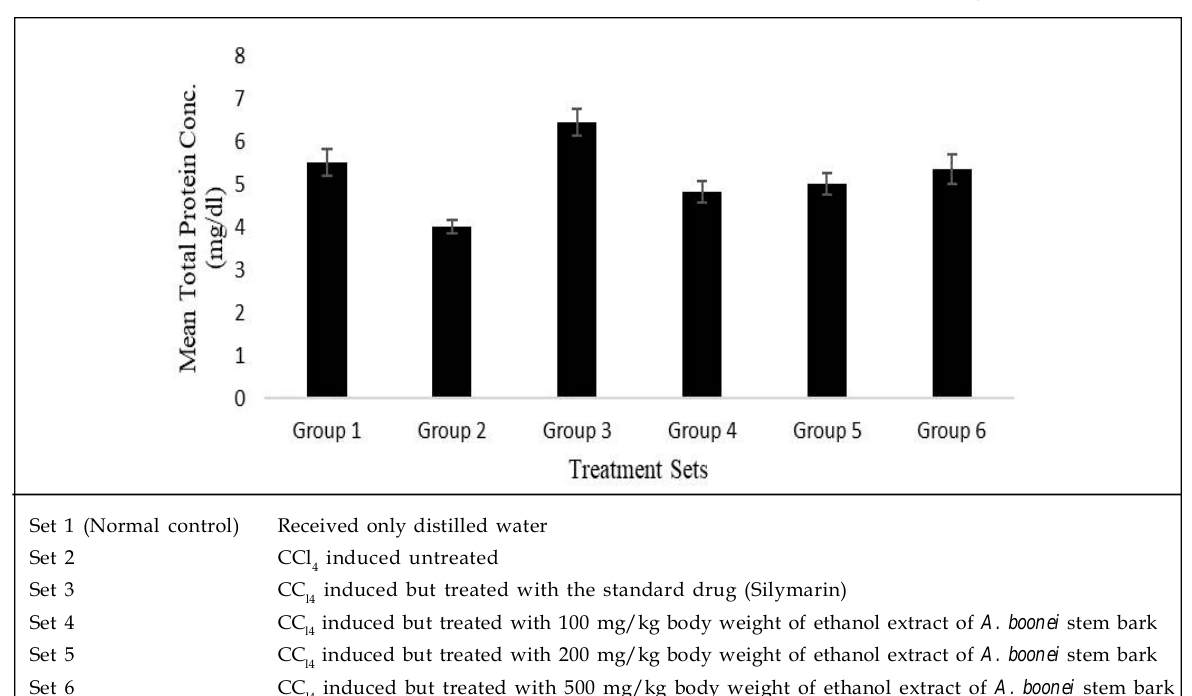
induced untreated 4